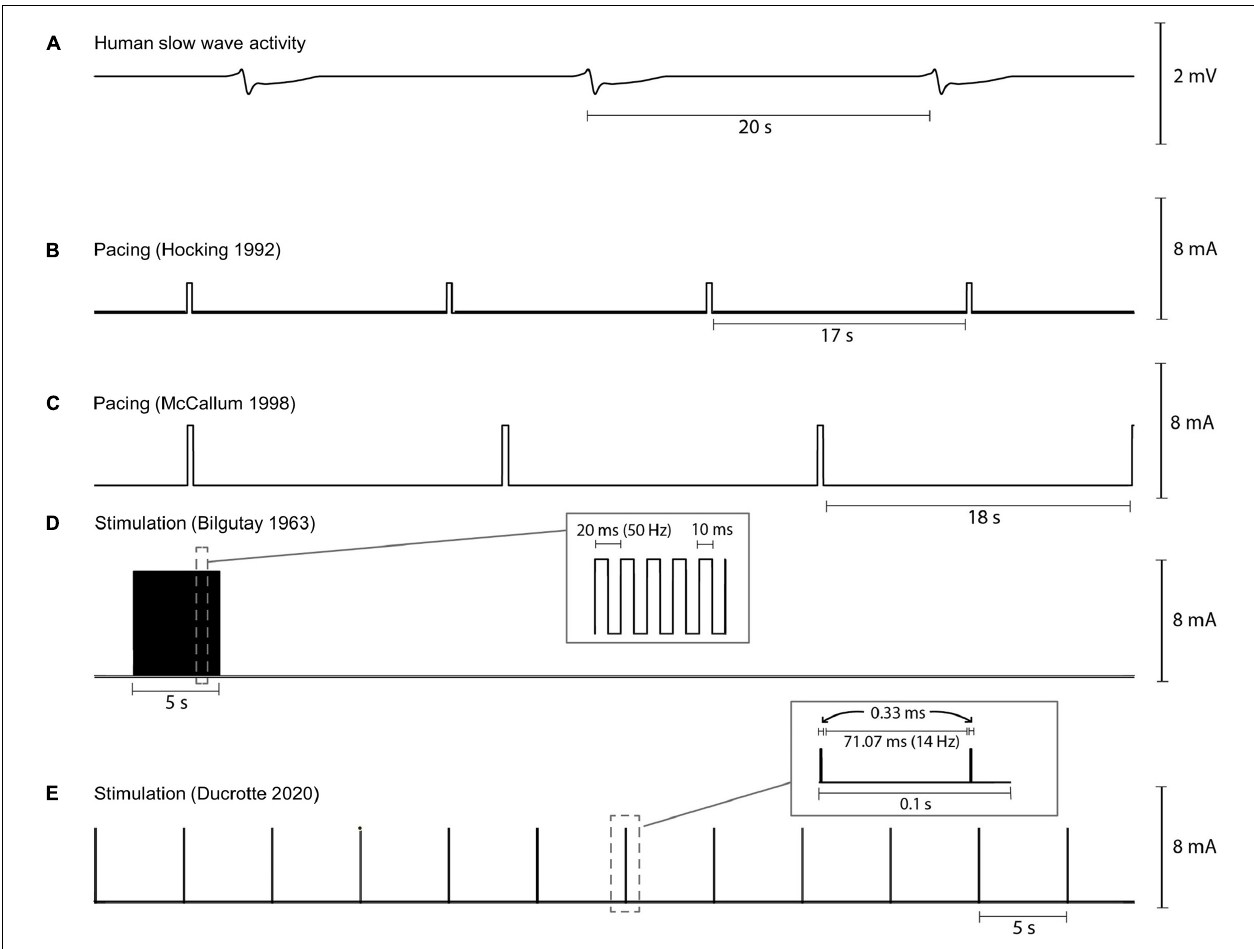
FIGURE 4 | Illustration of variability in pacing and stimulation pulses used by various researchers for human gastric pacing studies. (A) Normal gastric slow wave activity occurring at 3 cpm, (B,C) gastric pacing parameters as applied by Hocking et al. (1992) (2 mA, 350 ms, IF + 0.5 cpm) and McCallum et al. (1998) (4 mA, 350 ms, 110% IF), and (D,E) gastric stimulation parameters as applied by Bilgutay et al. (1963) (7 mA, 50 Hz, 5 s on period, 55 s off period) and Ducrotte et al. (2020) (5 mA, 14 Hz, 0.1 s on period, 5 s off period). IF: intrinsic